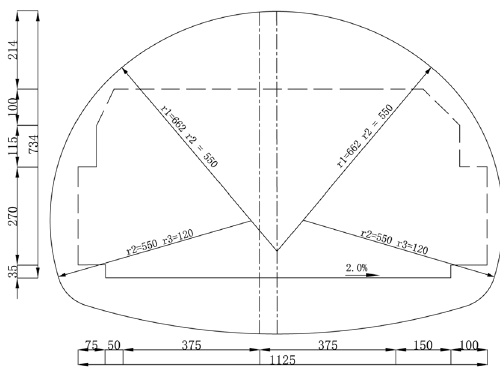
Figure 1. Horizontal profile of Shenmu No. 1 tunnel (unit: